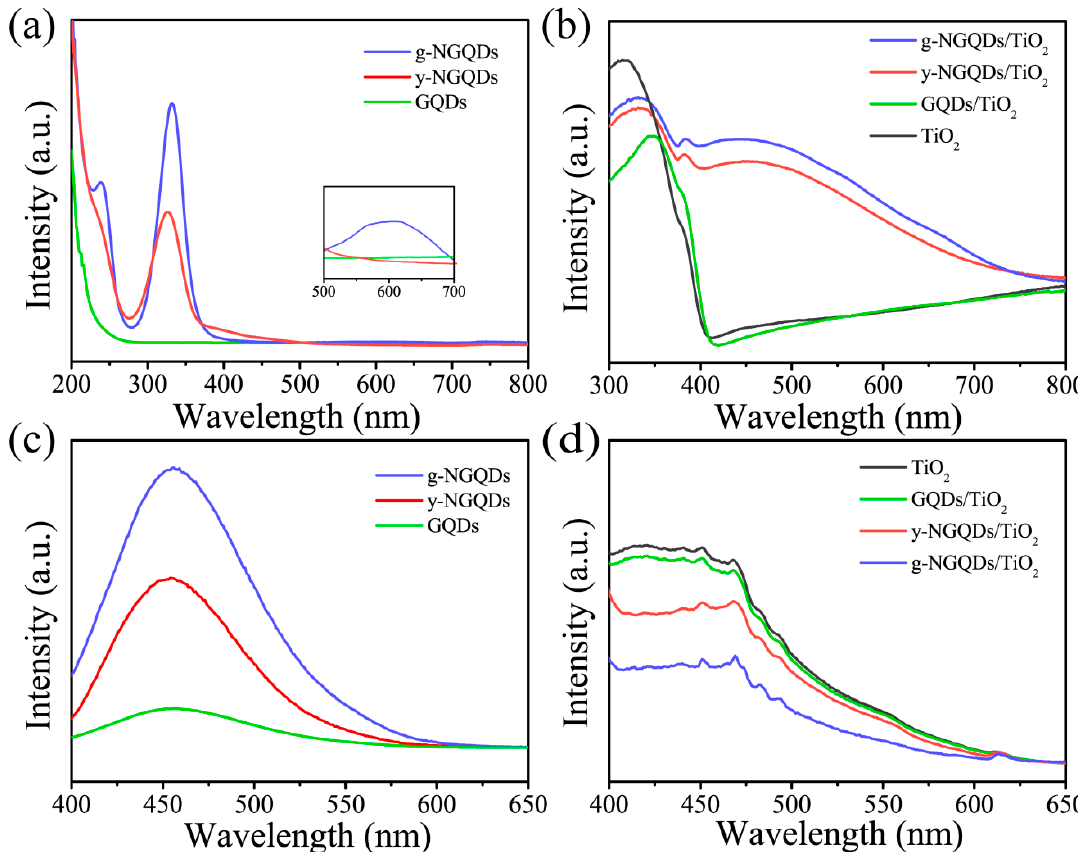
Figure 3. ( a ) UV-vis absorption spectra of the GQDs, g-NGQDs and y-NGQDs (The inset was an enlarged illustration of the original UV-vis absorption spectra ranged from 500 nm to 700 nm). ( b ) UV-DRS spectra of TiO 2 , GQDs/TiO 2 , g-NGQDs/TiO 2 and y-NGQDs/TiO 2 composites; ( c ) Comparison of PL spectra with excitation at 360 nm for GQDs, g-NGQDs and y-NGQDs; ( d ) Comparison of PL spectra with excitation at 360 nm for TiO 2 , GQDs/TiO 2 , g-NGQDs/TiO 2 and y-NGQDs/TiO 2 composites.